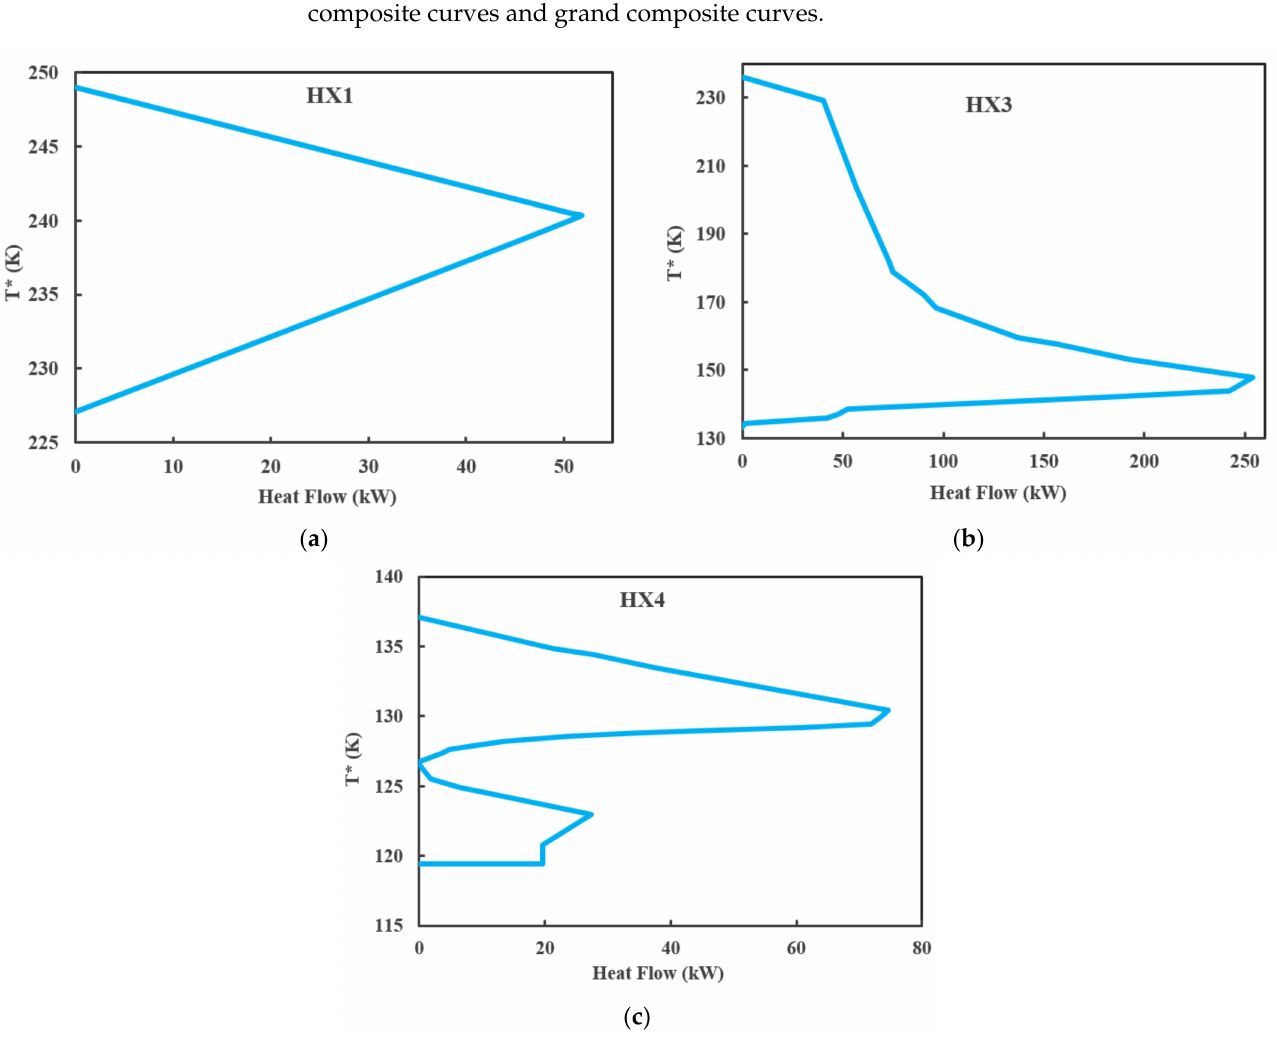
Figure 8. Grand composite curves (GCC) for ( a ) HX1, ( b ) HX3, and ( c )